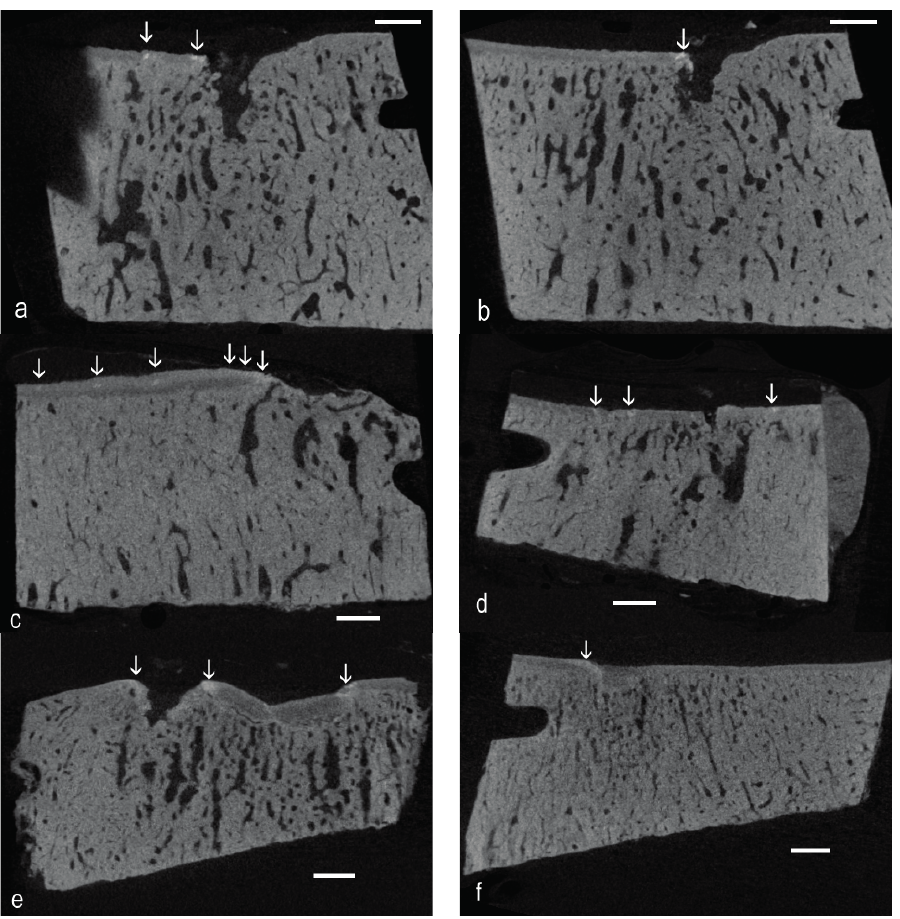
Figure 1. Unprocessed single XY plane images from Z stacks in which there are localized patches (vertical arrows) with higher density below the level of the mineralizing front of the articular calcified cartilage (ACC). Scale bars = 1 mm. ( a ) Eight-year-old, which showed the highest number of easily-spotted high-density mineral infill (HDMI) fields in a control sample; ( b ) Parallel slice at 360 µm; ( c ) Advanced OA, five-year-old; ( d ) Advanced OA, four-year-old; ( e ) Early OA, two-year-old; and ( f ) Early OA, same two-year-old, but in the more palmar